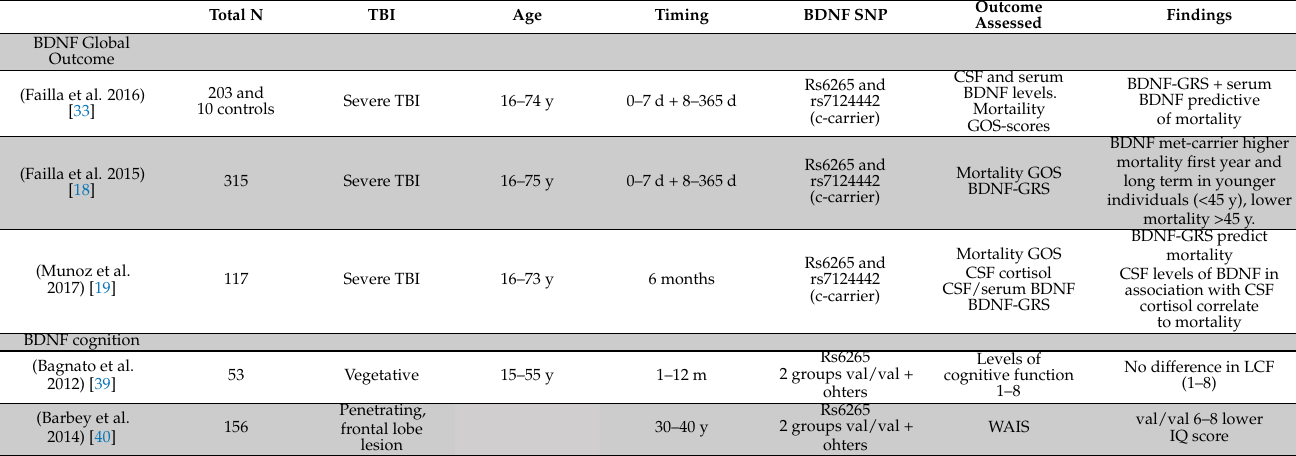
Table A1. Overview of the reviewed studies examining humans and a short summary of their reported